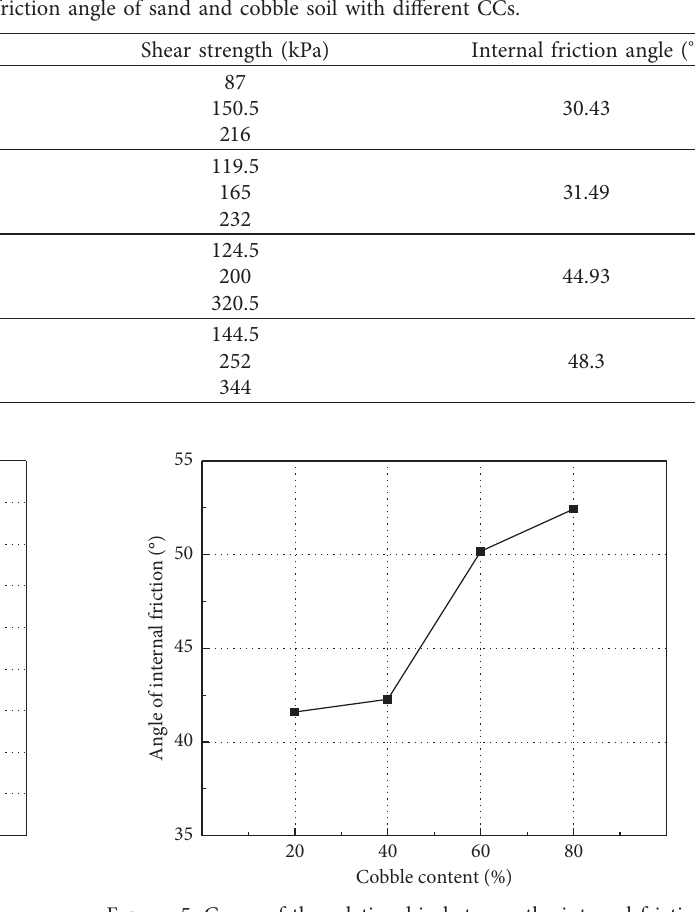
Figure 5: Curve of the relationship between the internal friction angle and